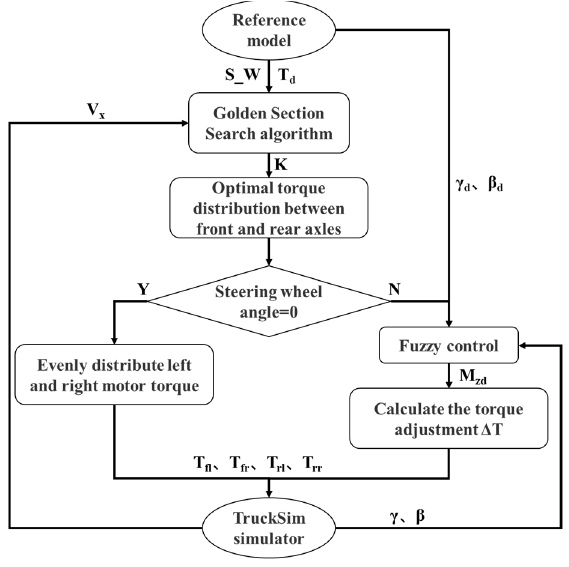
Figure 2. The structure of the DDEV torque control strategy.